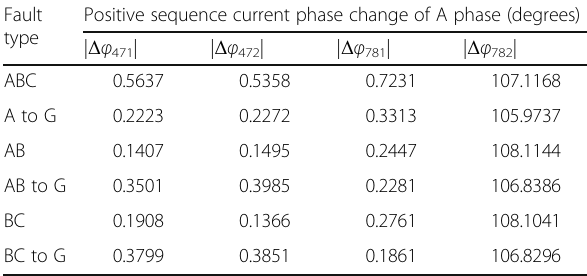
Table 2 Evaluation data and result (portion) Current